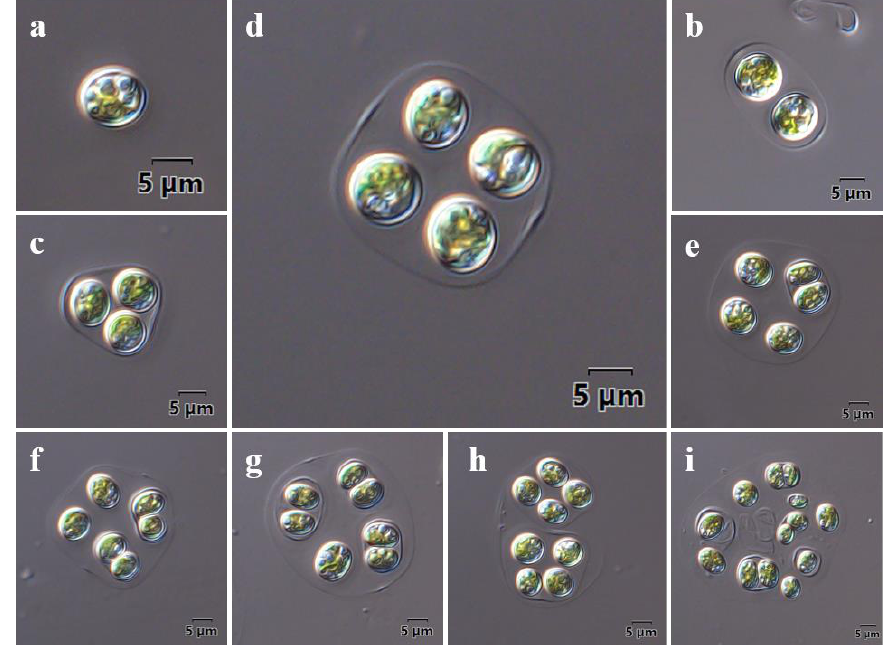
Figure 1. Light microscopy of Euchlorocystis marina . ( a ) Solitary cell; ( b ) 2-celled colony; ( c ) 3-celled colony; ( d ) 4-celled colony; ( e ) 5-celled colony; ( f ) 6-celled colony; ( g ) 7-celled colony; ( h ) 8-celled colony; ( i ) 13-celled